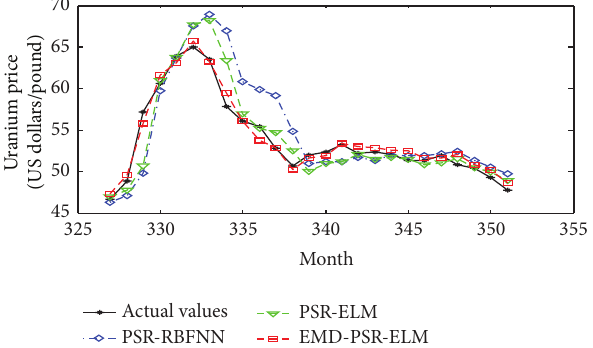
Figure 8: Out-of-sample forecasting by different models.